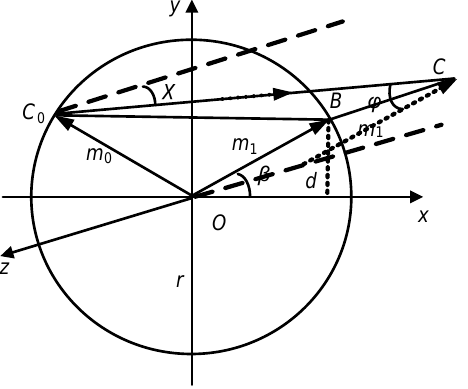
Figure 3. Skew rays of two successive